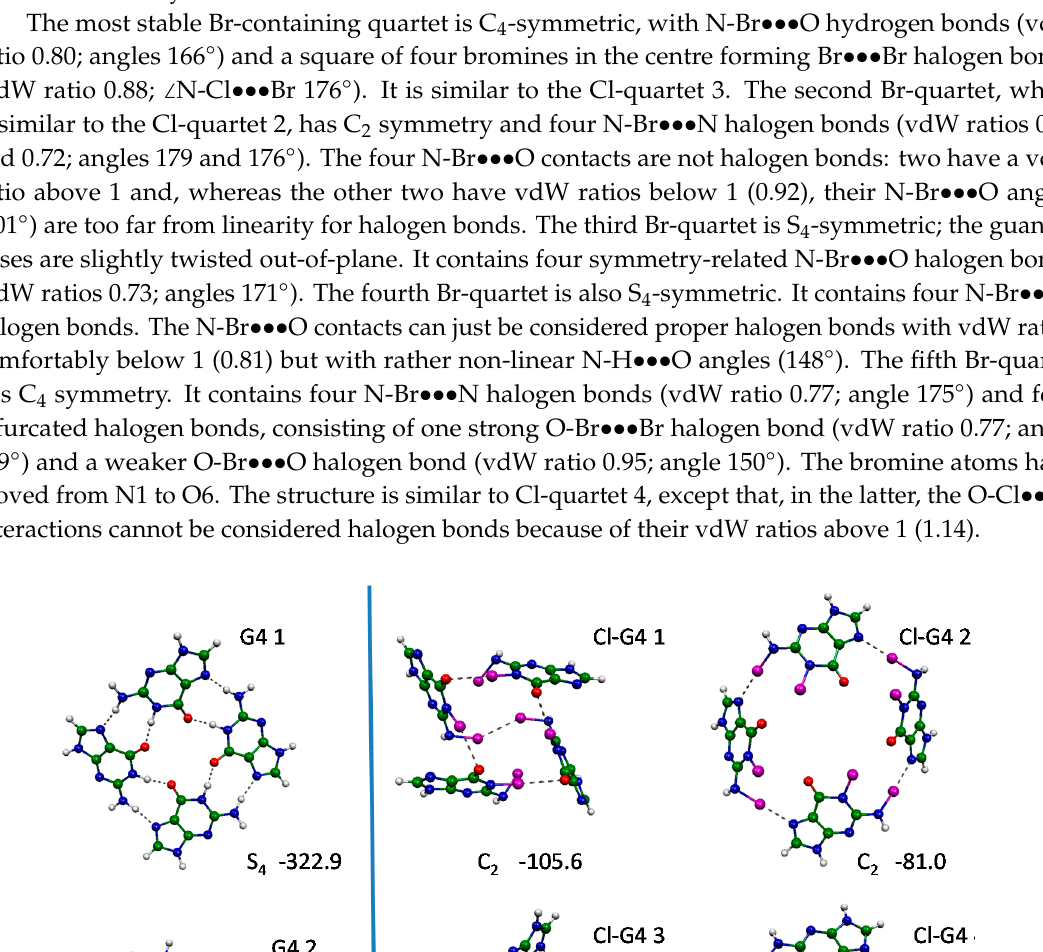
Table 4. Selected geometrical parameters (distances in Å; angles in degrees) and van der Waals ratios (vdW) for the R-II dimers and trimers.